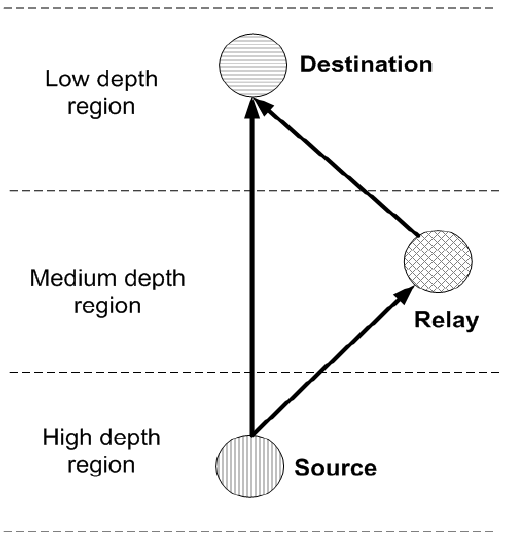
Figure 2. Rule 3: D